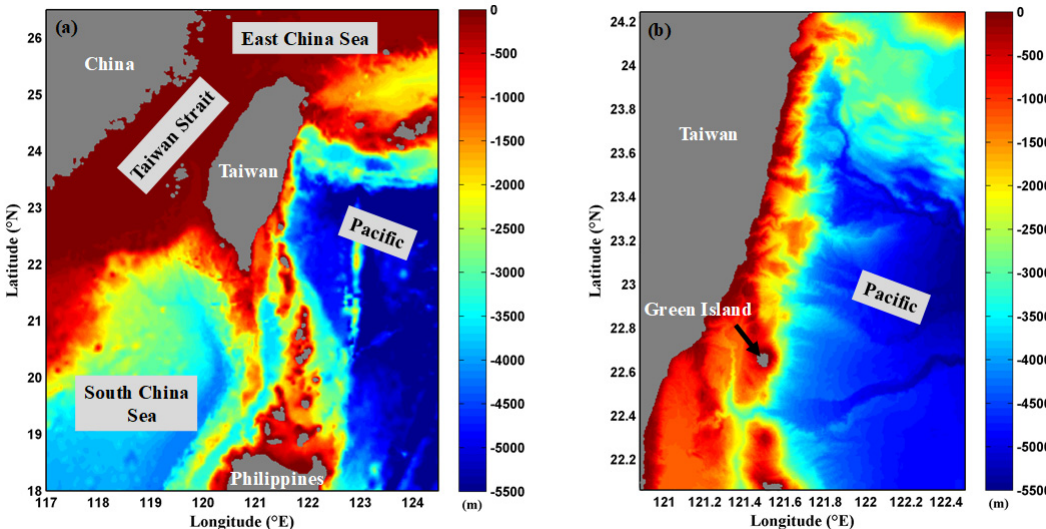
Figure 2. Bathymetry of ( a ) the TW and ( b ) GI models.